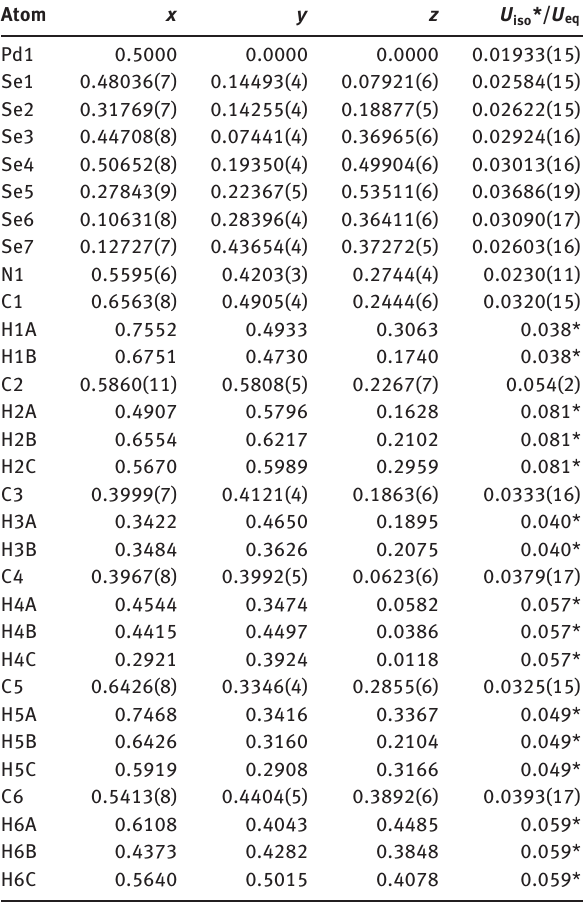
Table 2: Fractional atomic coordinates and isotropic or equivalent isotropic displacement parameters (Å 2